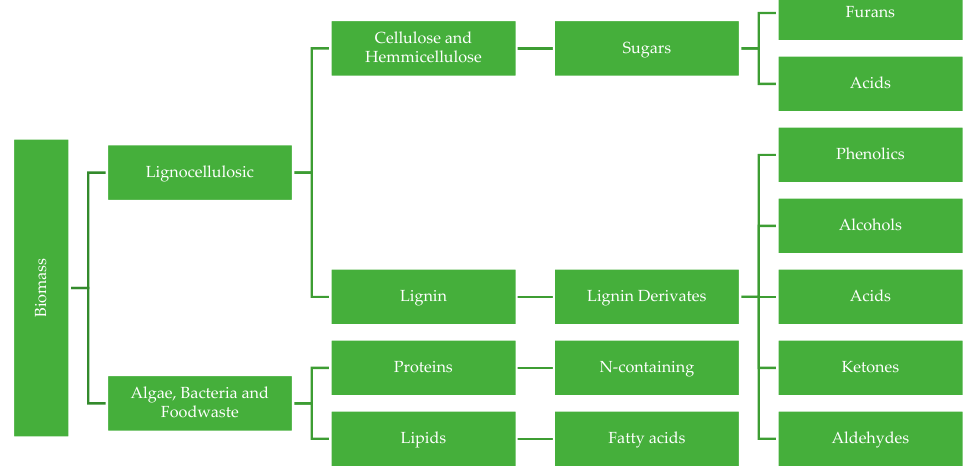
Figure 2. Proposed chemical groups derived from biomass components.